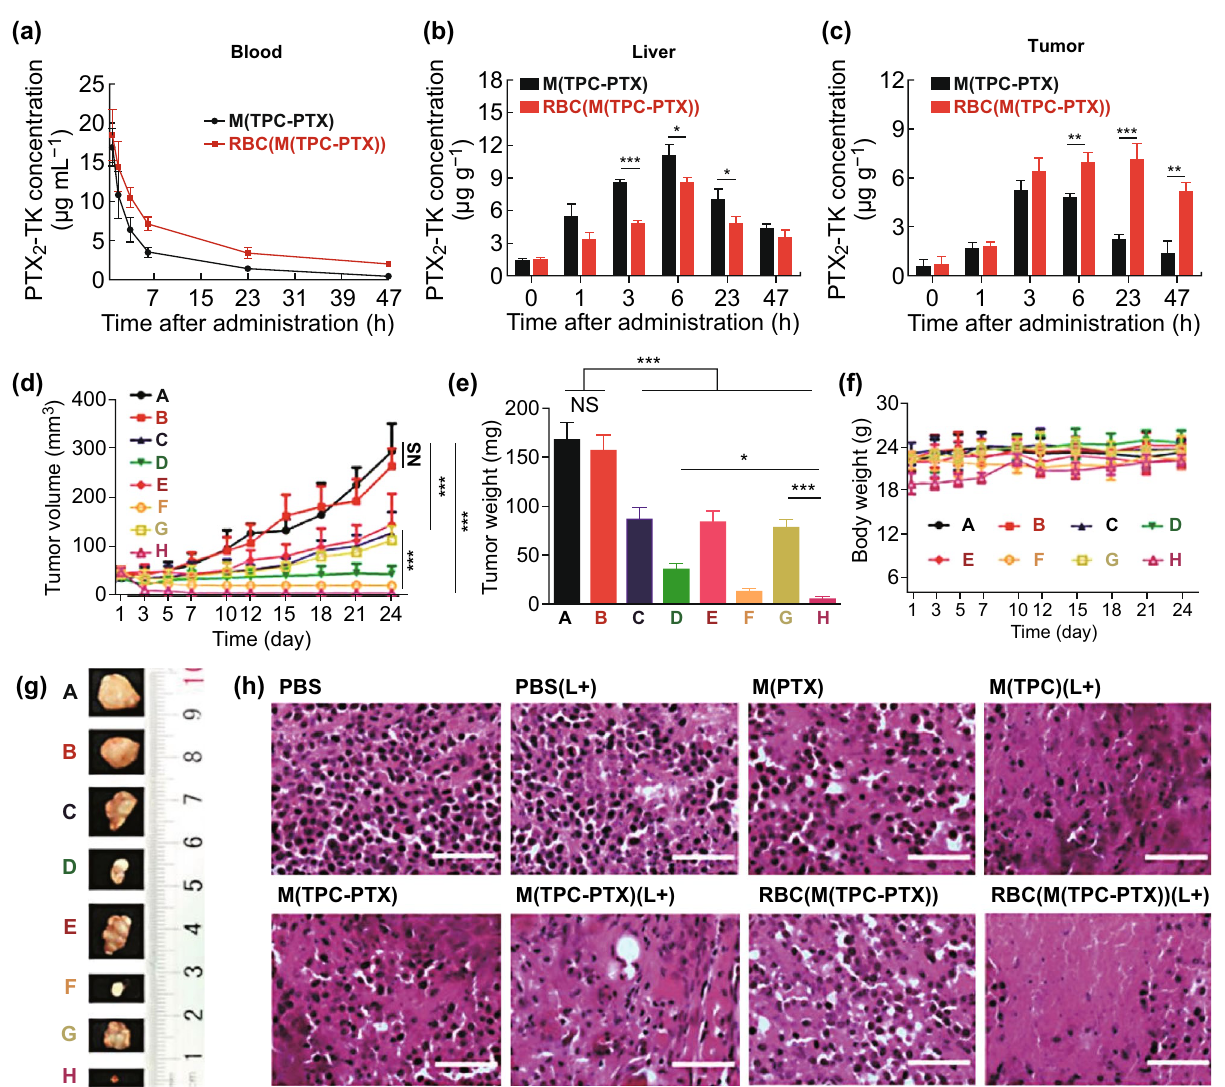
Fig. 4 a Mice ( n = 4) were i.v. administered drug‑loaded NPs with or without an RBC membrane coating, using a 15 mg kg −1 PTX equivalent dose. PTX 2 ‑TK levels in b the liver and c tumor were assessed at specific time points following NP administration. d Tumor volume changes in mice treated with a range of formulations (PBS, PBS (L+), M(PTX), M(TPC) (L+), M(TPC‑PTX), M(TPC‑PTX) (L+), RBC(M(TPC‑PTX)) and RBC(M(TPC‑PTX)) (L+)). L+ indicated laser. e Tumor weights of mice treated as in d . f Body weights of mice over time. g Ex vivo tumor images, as indicated. h Tumor sections were H&E‑stained following the indicated treatments. Scale bar = 200 µm. Data d‑g are mean ± SEM ( n = 6). *p < 0.05, **p <0.01, and ***p <0.001. Adapted from Ref. [95] with